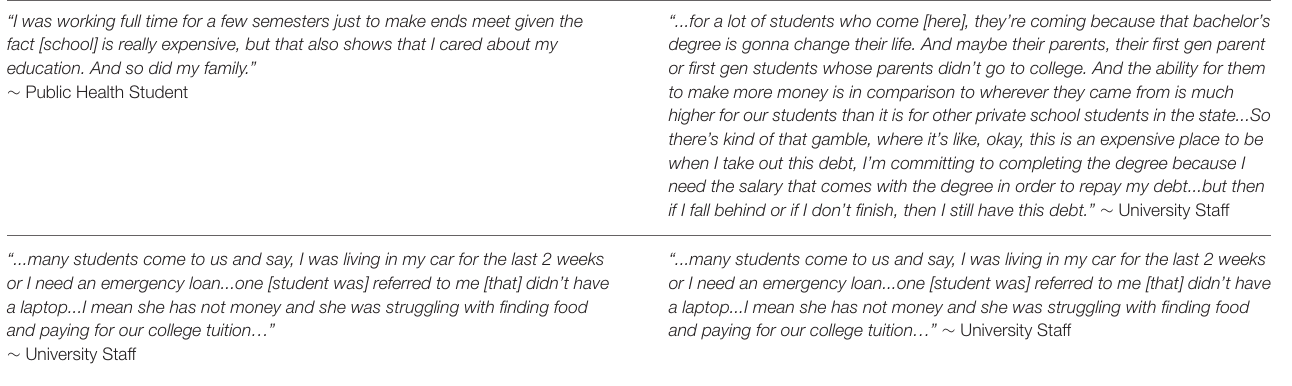
TABLE 6 | Material needs: illustrative comments from study